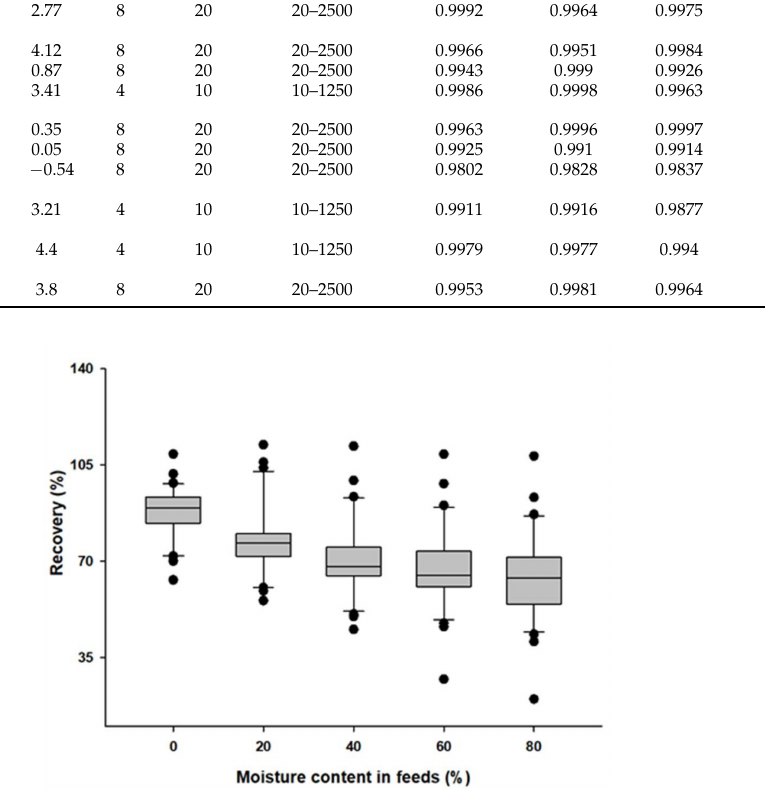
Figure 2. Effect of different moisture content in feeds on the recoveries of target compounds. All preparation was performed in triplicate using blank pet feed samples with moisture contents of 0, 20, 40, 60, and 80% w / w at middle validation levels ( n =